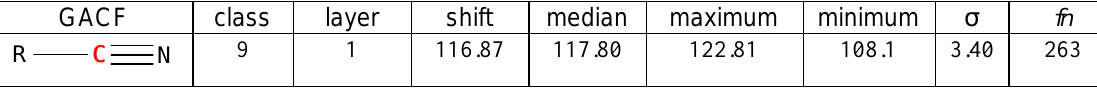
Table 2. The Format of GACF-Chemical Shift Correlation